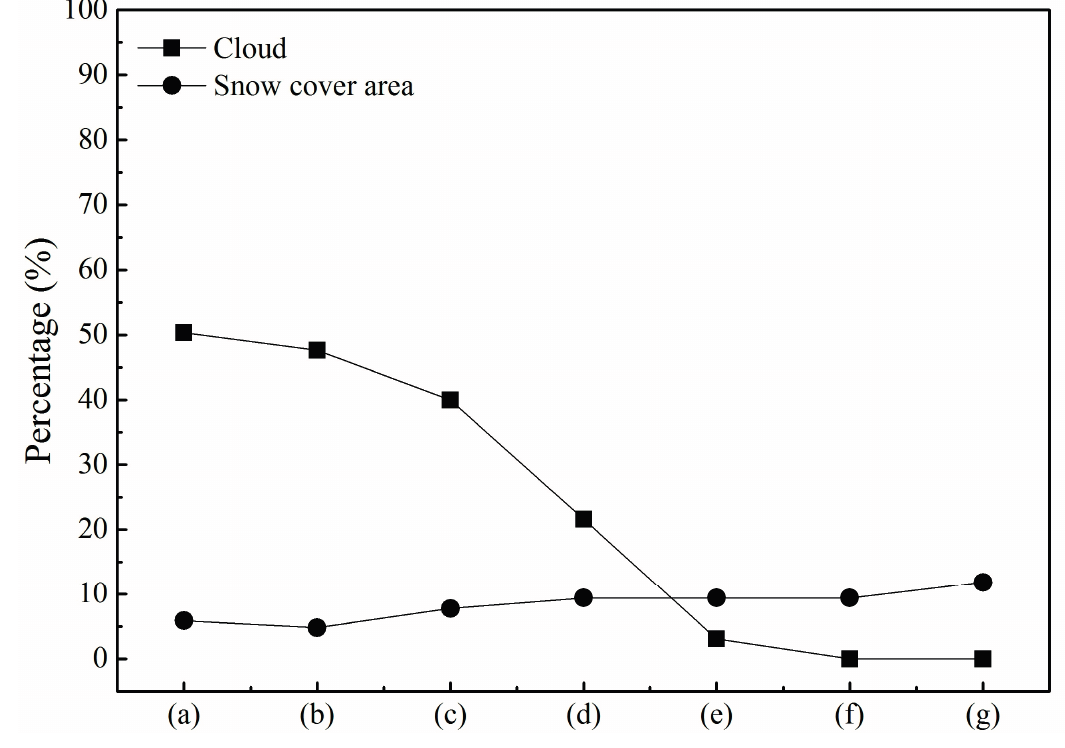
Figure 5. Plots of mean snow and cloud amount ratios during the different composite stages during November 2013 to February 2014. ( a ) MOD10A1; ( b ) MYD10A1; ( c ) morning and afternoon composite map; ( d ) day-before-and-after composite map; ( e ) SNOWL with cloud removed; ( f ) composite map with AMSR2; ( g ) daily cloud-free FSC